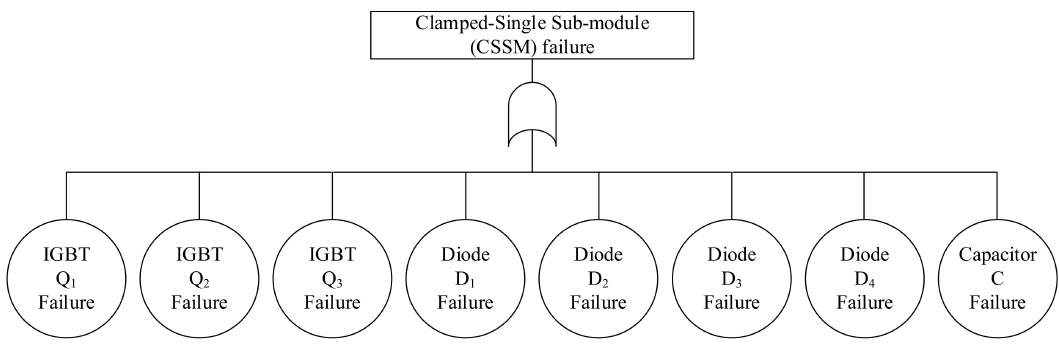
Figure 7. Fault dependence of the